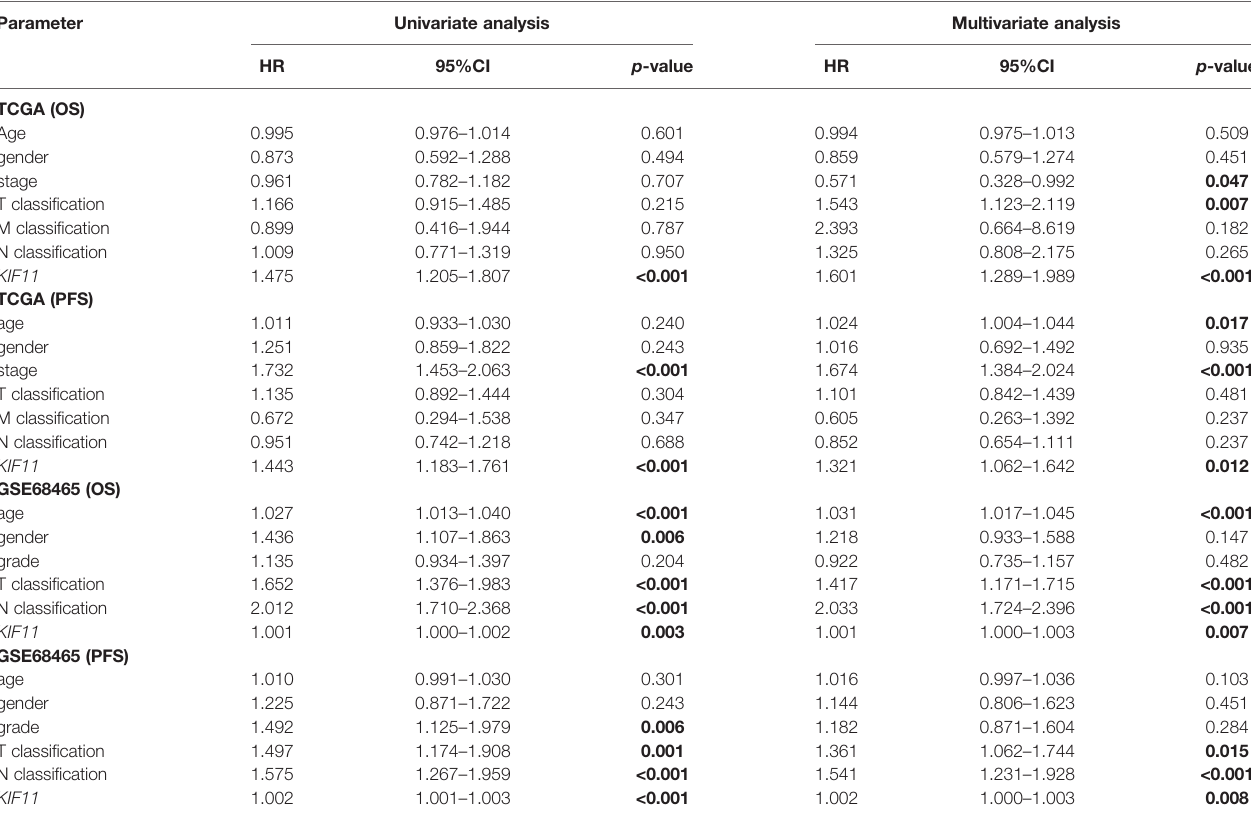
TABLE 1 | Cox regression analysis for KIF11 expression on OS and PFS of LUAD patients. Parameter Univariate analysis Multivariate